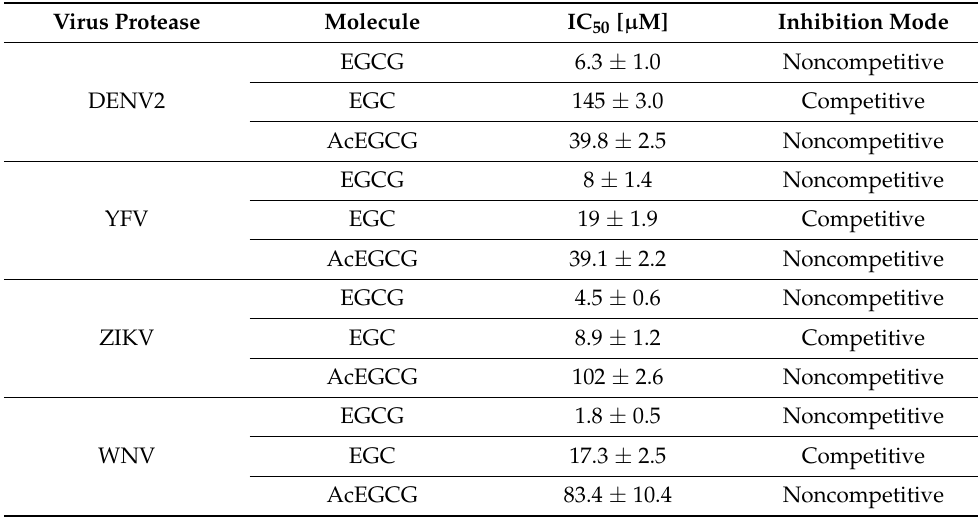
Table 5. IC 50 values and inhibition mode of the epigallocatechin molecules. Virus Protease